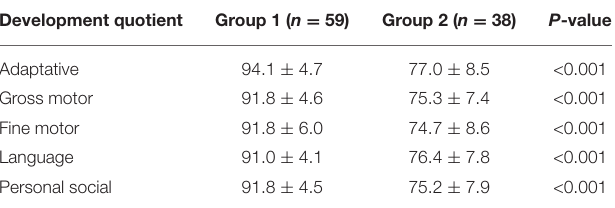
TABLE 3 | Neurodevelopmental outcome of isolated PVPCs and PVPCs with additional findings. Development quotient